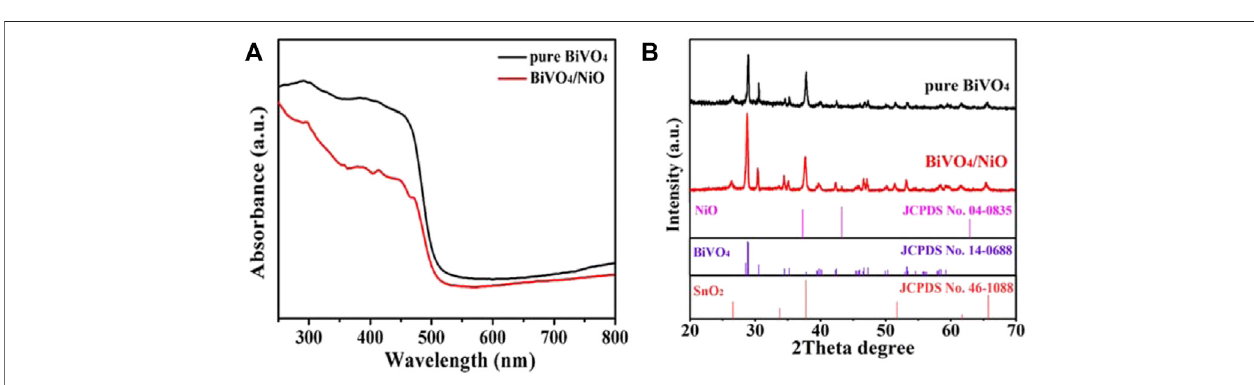
(B) XRD patterns of the BiVO 4 and BiVO 4 /NiO. 4 and BiVO 4 /NiO photoanodes.